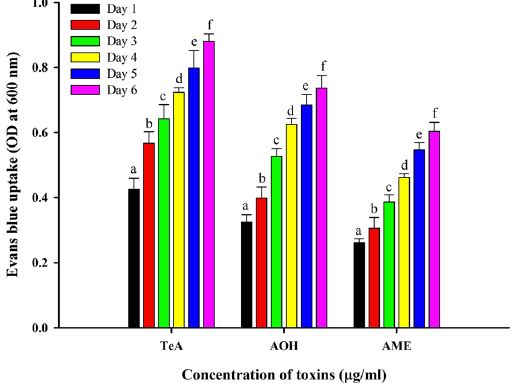
Figure 8. Cell death assay by uptake of Evans blue stain in the leaves of tomato plant treated with Alternaria toxins (AME, AOH and TeA) at different days intervals. The results are expressed as mean of three replicates and the vertical bars showed the ± SD of the mean. Different letters indicate that the values are significantly different from each other ( P ≤